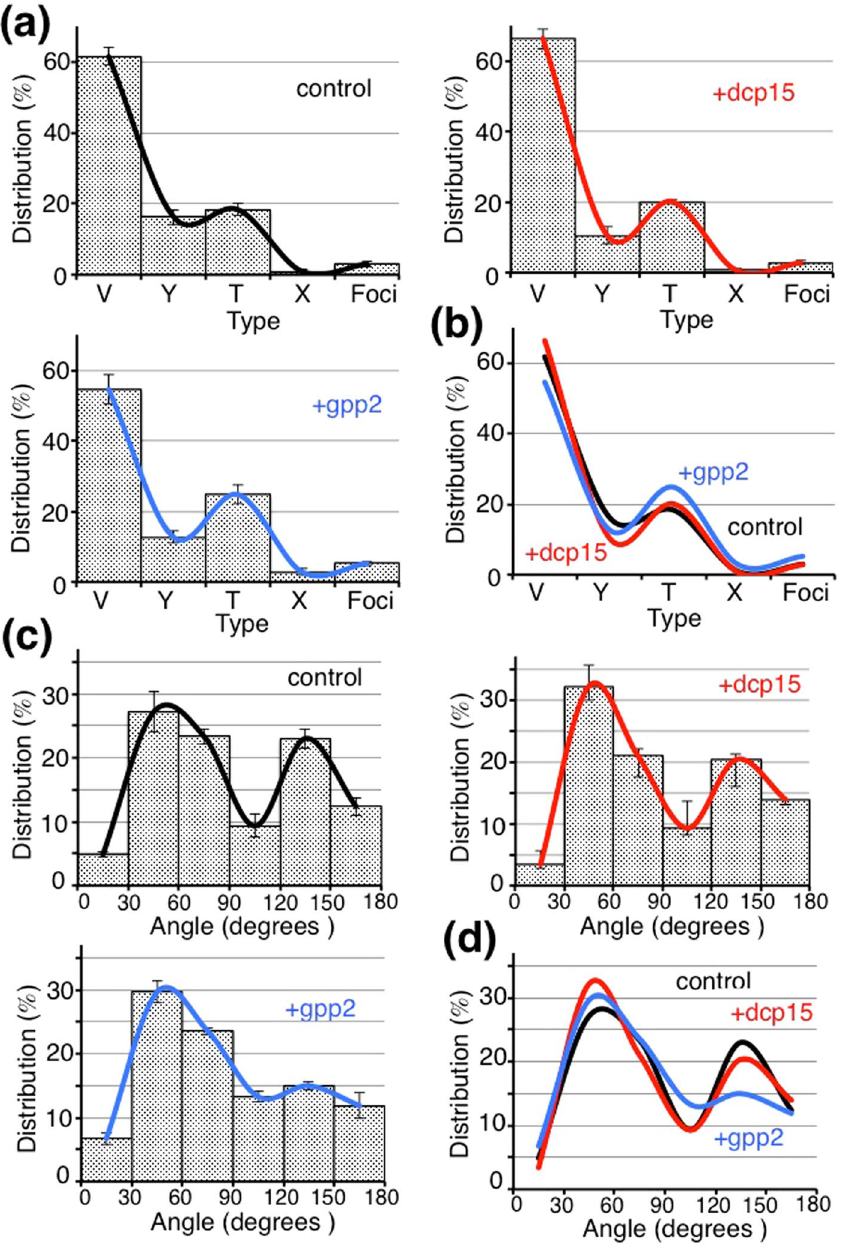
Figure 2. Distribution of intersection types and deflected angles. ( a ) Distribution ratio of intersection types, including V-, Y-, T-, X- and Foci types (control, n = 317; + dcp15, VE pretreated with dcp15, n = 224; + gpp2, VE pretreated with gpp2, n = 435). Averaged data were also fitted (mean ± SEM, n = 4). ( b ) Fitted curves were overlaid (Black, Red and Blue for control, dcp15 and gpp2, respectively). ( c ) Deflected angles at intersection were measured (control, n = 365; + dcp15, VE pretreated with dcp15, n = 318; + gpp2, VE pretreated with gpp2, n = 677). Averaged data were also fitted (mean ± SEM, n = 4). ( d ) Fitted curves were overlaid (Black, Red and Blue for control, dcp15 and gpp2,